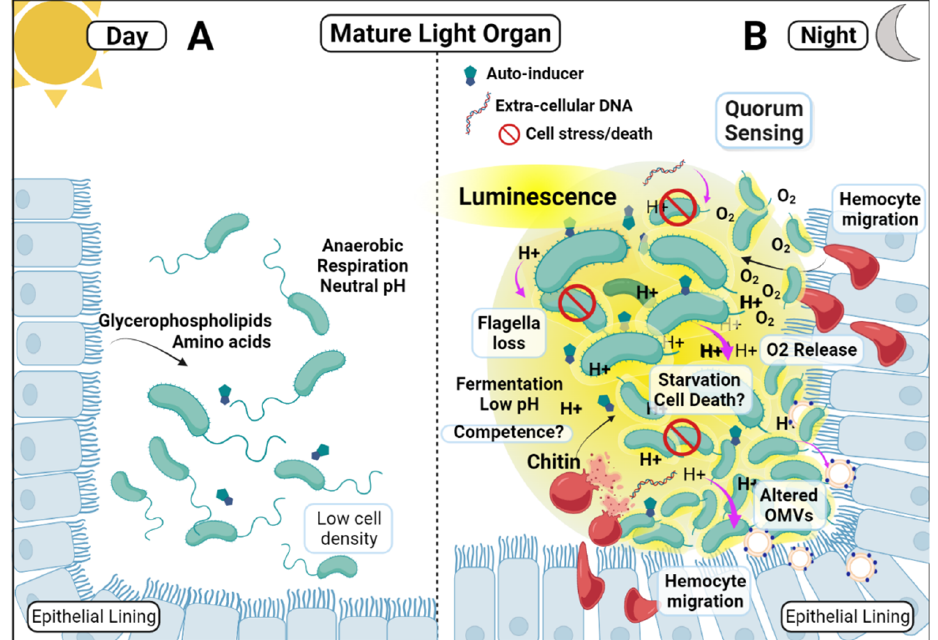
Figure 3. Nocturnal acidification of the mature light organ as a central cue coordinating many of the regulatory signal networks that maintain the symbiosis. ( A ) The matrix of a light organ crypt at dawn when the population of remnant symbionts has not yet repopulated the crypt to a high cell density. Host-provided nutrients are metabolized through anaerobic respiration with no lowering of matrix pH. Flagella may be present, having been induced just prior to the dawn venting. ( B ) Acidification-cued interactions present at the end of the night. Quorum signaling is driving bioluminescence. Fermentation of host-provided chitin lowers the matrix pH and attracts hemocytes which release O 2 . Lowered pH cues production of altered OMVs, while also facilitating several of the four known cardinal inducers of natural competence and transformation. Pre-adaptive flagellar gene transcription is cued shortly before the dawn venting.